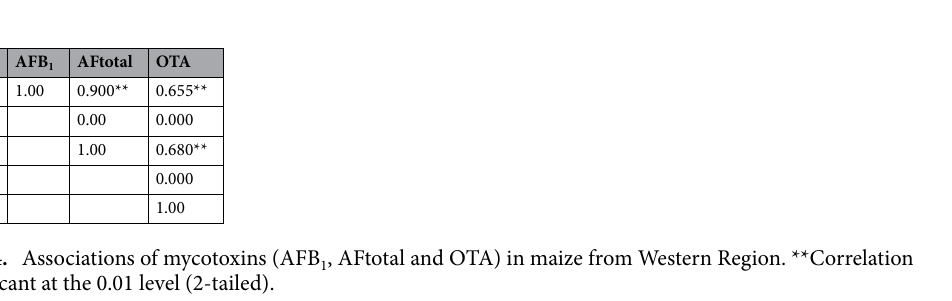
(Table 17). In the Eastern Region, the EDI values recorded for infants, toddlers, children, adolescents, and adults were 330, 96, 70, 40, and 30 ng/kg bw/day, respectively. MOE values recorded were 0.05, 0.19, 0.26, 0.45, and 0.60, respectively. The average potency was the same while the Cancer risks were 10.66, 3.10, 2.26, 1.29, and 0.97 cases/100,000 person/year, respectively (Table 17). In the Central Region, the EDI values recorded for infants,